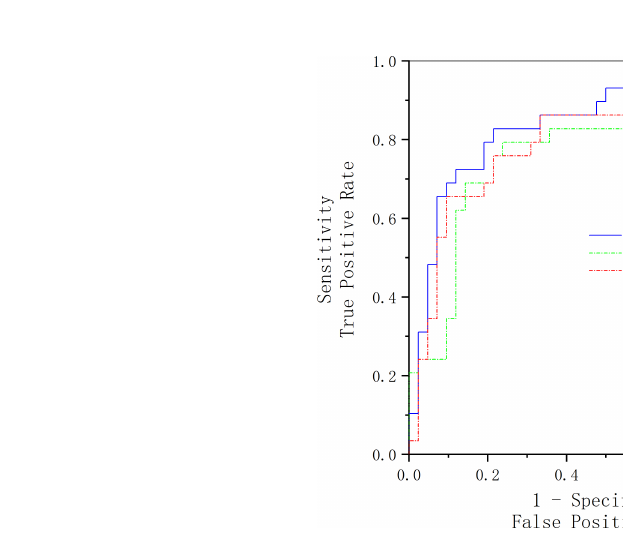
FIGURE 5 Comparison of classi fi cation results of three classi fi cation methods.